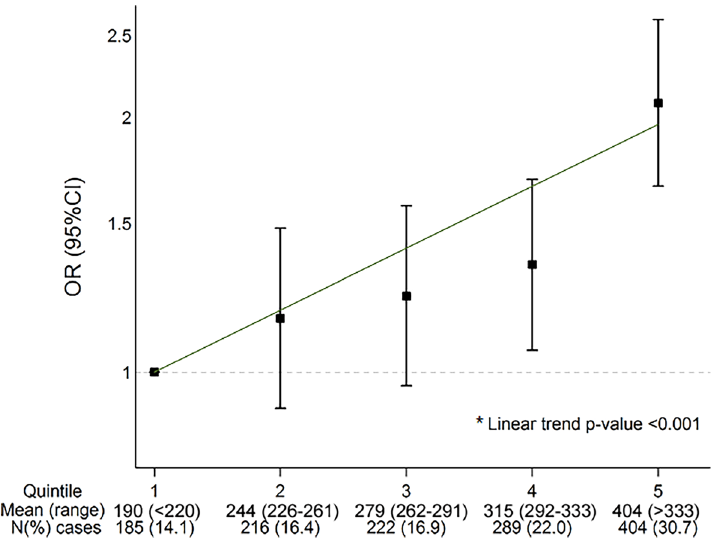
Figure 1. Association between uric acid quintiles and presence of pre-eclampsia after adjustment for maternal age. Mean (range) for quintiles given in μmol/L.